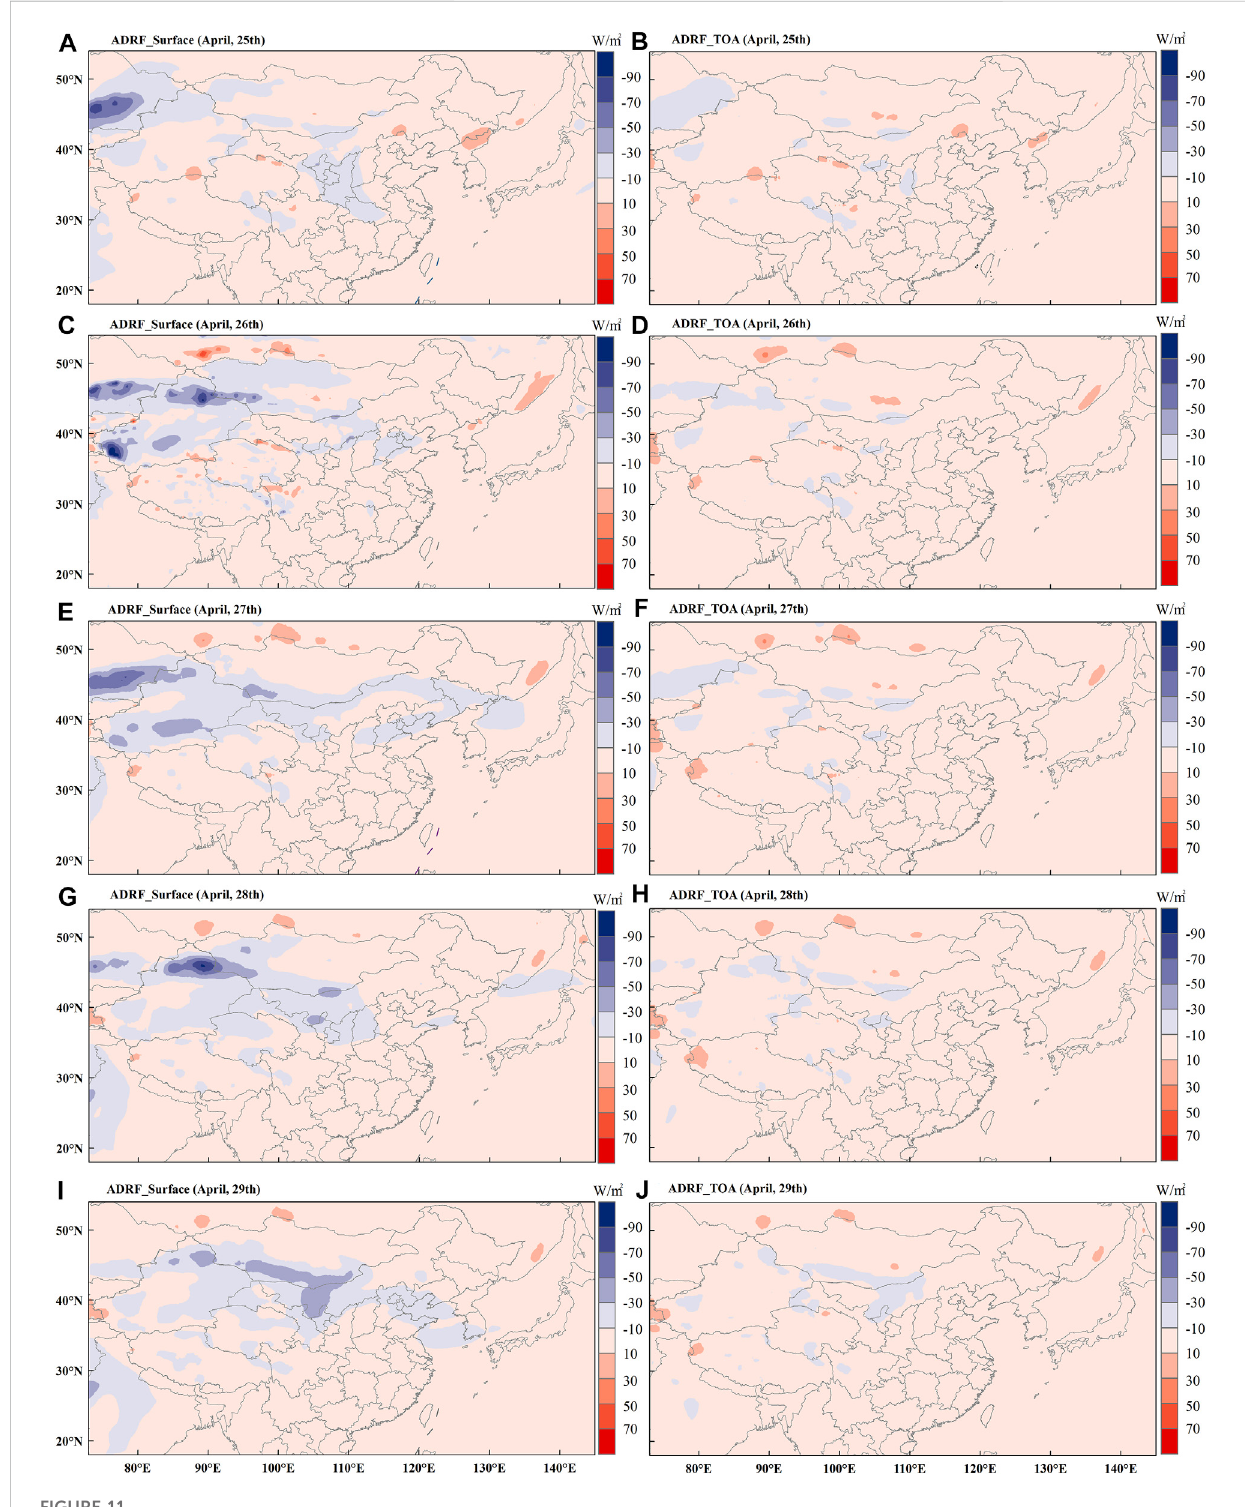
FIGURE 11 Spatial distributions of ADRF SUR (A, C, E, G, and I) and ADRF TOA (B, D, F, H, and J) from dust aerosols in eastern Asia during April 25 – 29,